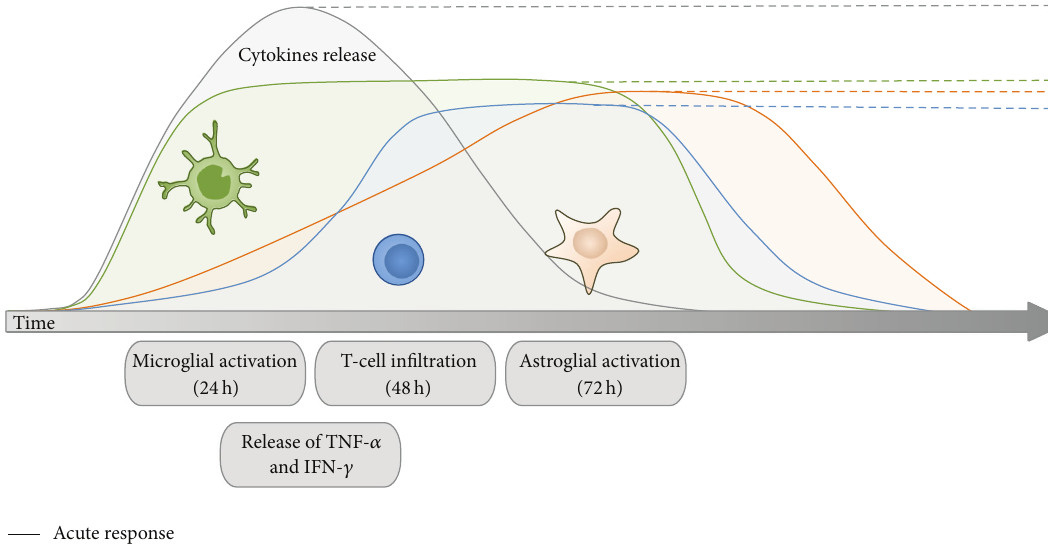
Figure 1: Timing of cytokine release, glial activation, and T-cell infiltration in the inflammatory response in Parkinsonism. Within 24 h, cytokine release and microglial activation can be clearly observed. According to the protocol of dopaminergic cell death induction, cytokine release and microglial activation can be resolved around 72 h. Maximum peak of T-cell infiltration can be achieved at 48 h after dopaminergic insult. Astroglial activation can be seen at 24h but reaches the maximum peak at 72h. Depending on the protocol of dopaminergic cell death induction used, the inflammatory response may be resolved within